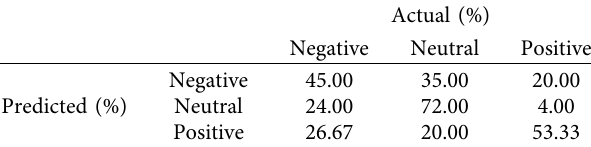
Table 9: Confusion matrix of the SVM